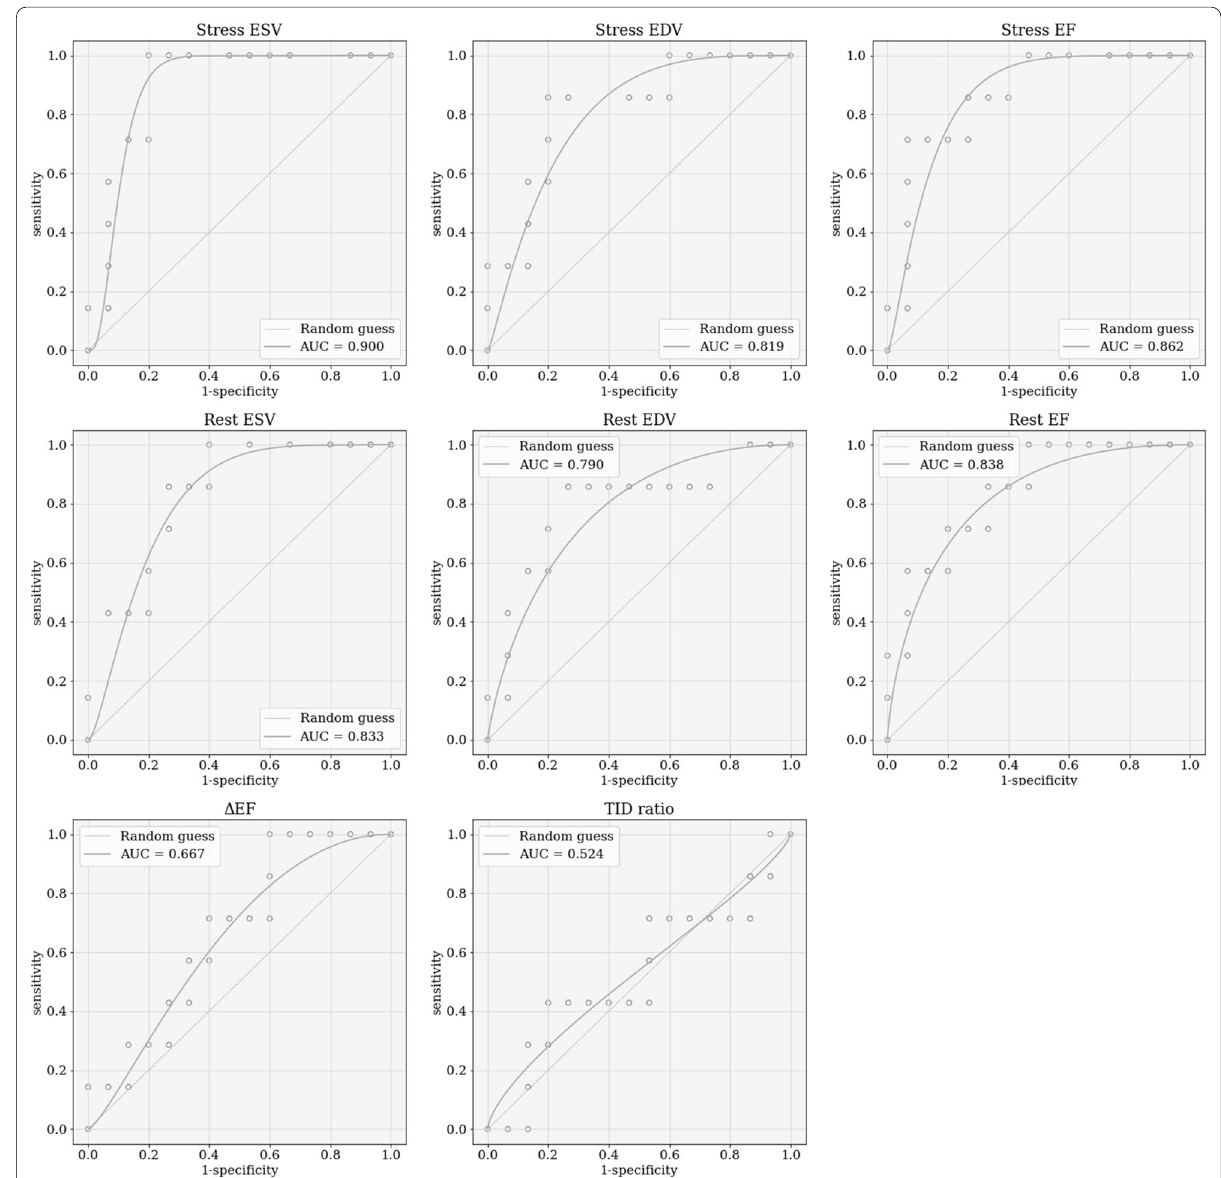
Fig. 3 ROC curve of stress ESV, stress EDV, stress EF, rest ESV, rest EDV, rest EF, ΔEF and TID ratio in patients with and without